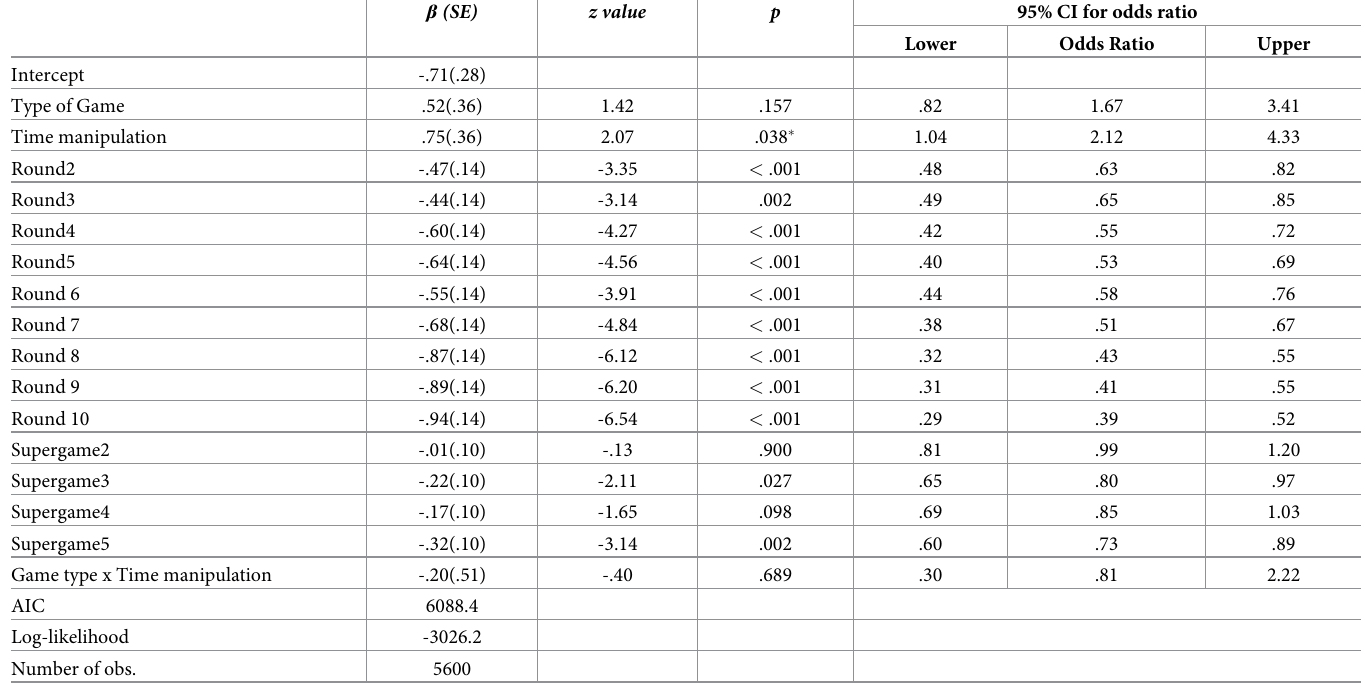
Table 4. Estimates of the logistic regression model for cooperation probability in the first 50 rounds